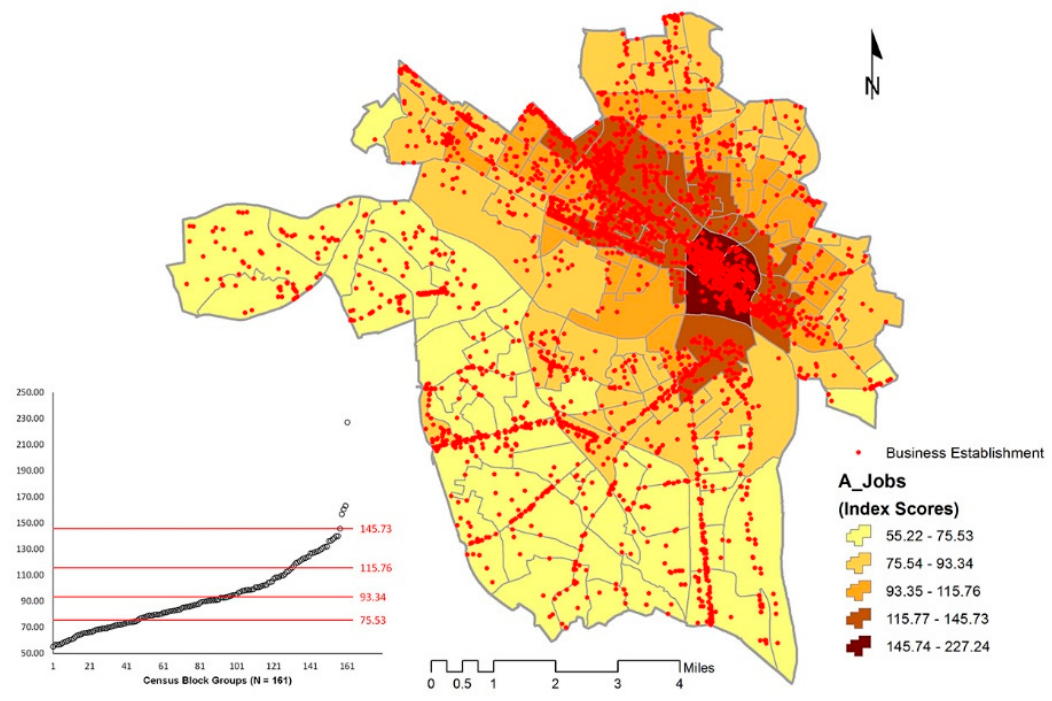
Figure 8. Accessibility to jobs of Census Block Groups in the City of Richmond.